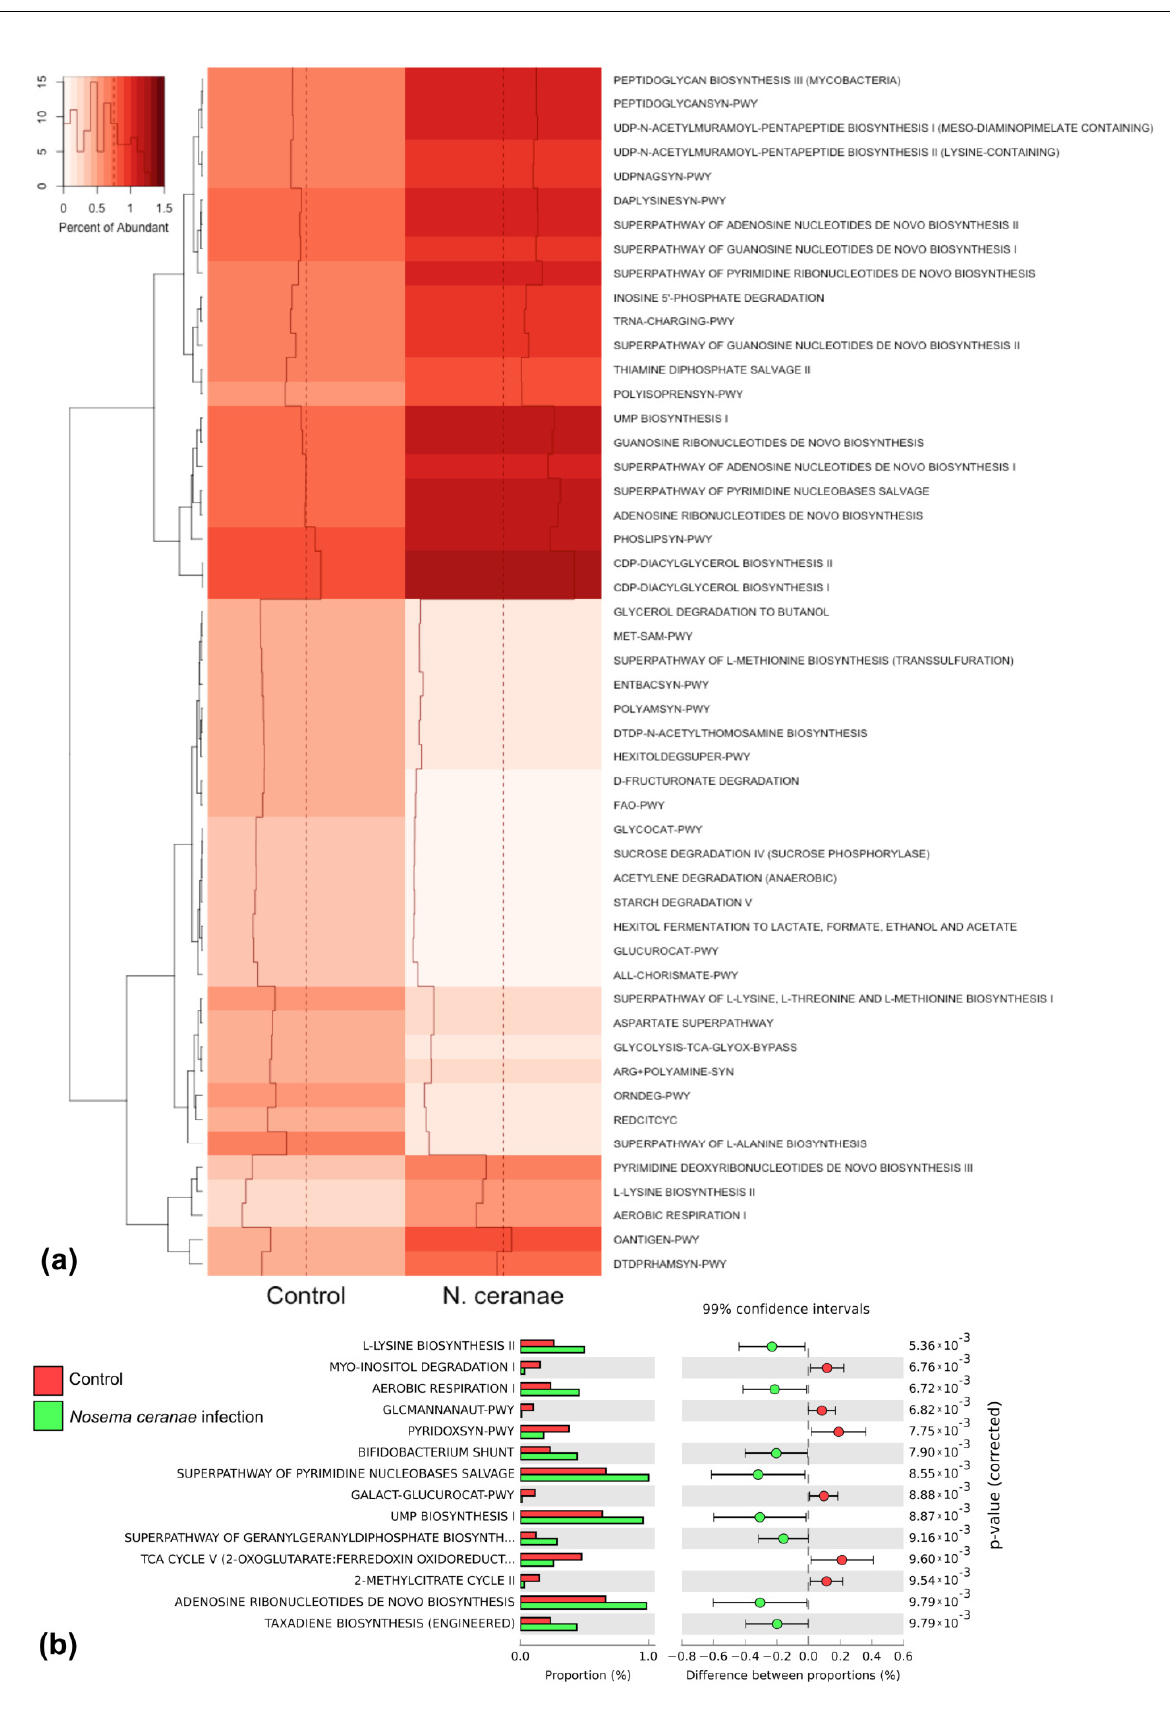
Figure 5. The functional genes prediction analysis of Nosema-infection honey bee. Functional gene expression heat map of control and Nosema-infected A. mellifera that showed the different of functional gene ( a ) with part of p -value of the difference between proportion chart ( b ). The full p -value chart is shown in Figure S4.